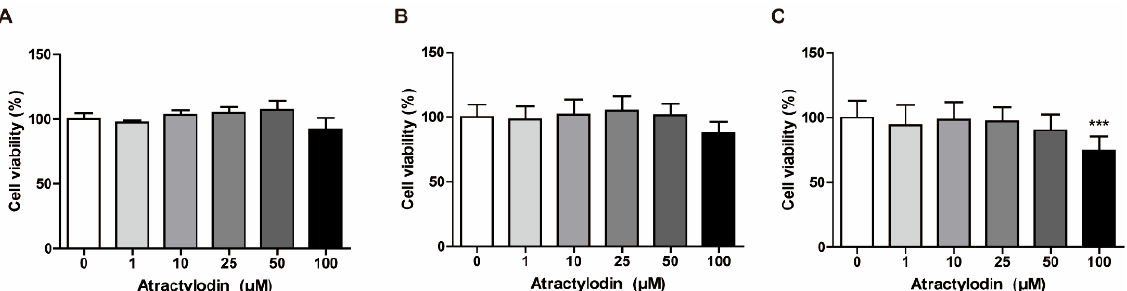
Figure 1. Determination of a non-cytotoxic working concentration of atractylodin in colonic epithelial cells. Cell viability was investigated using an MTT assay. ( A ) NCM460, ( B ) SW480, and ( C ) HCT116 cells were treated with vehicle (0.1% DMSO) or atractylodin at the indicated concentrations for 24 h (n = 6). Viabilities are presented as a percentage of the vehicle-treated group. *** p < 0.001 compared to the vehicle-treated group.